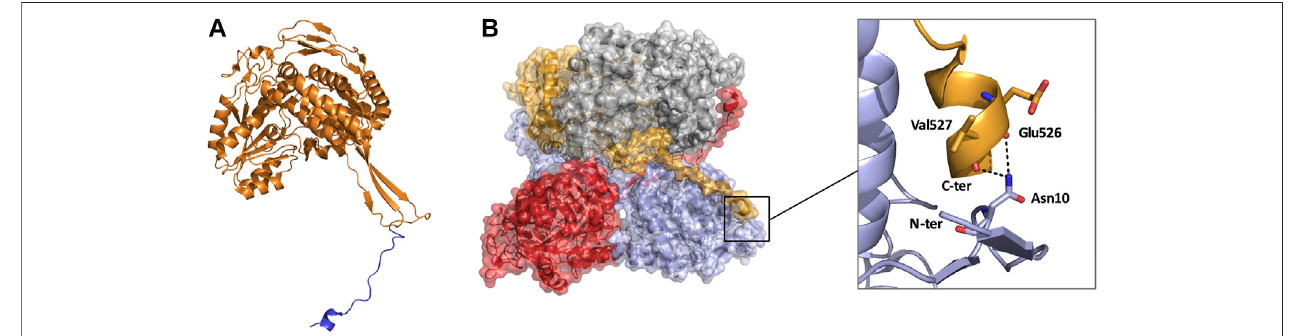
FIGURE 7| Monomeric and tetrameric structure ofTtALDH 530 (PDB: 6FJX). (A) Monomer highlighting the C-terminal extension in blue. (B) Surfacerepresentation ofthetetramericassembly,notehowtheC-terminaltailfromonemonomerwrapsitsdiagonal monomerandinteractswithitsN-terminus. Monomersarerepresented in contrasting